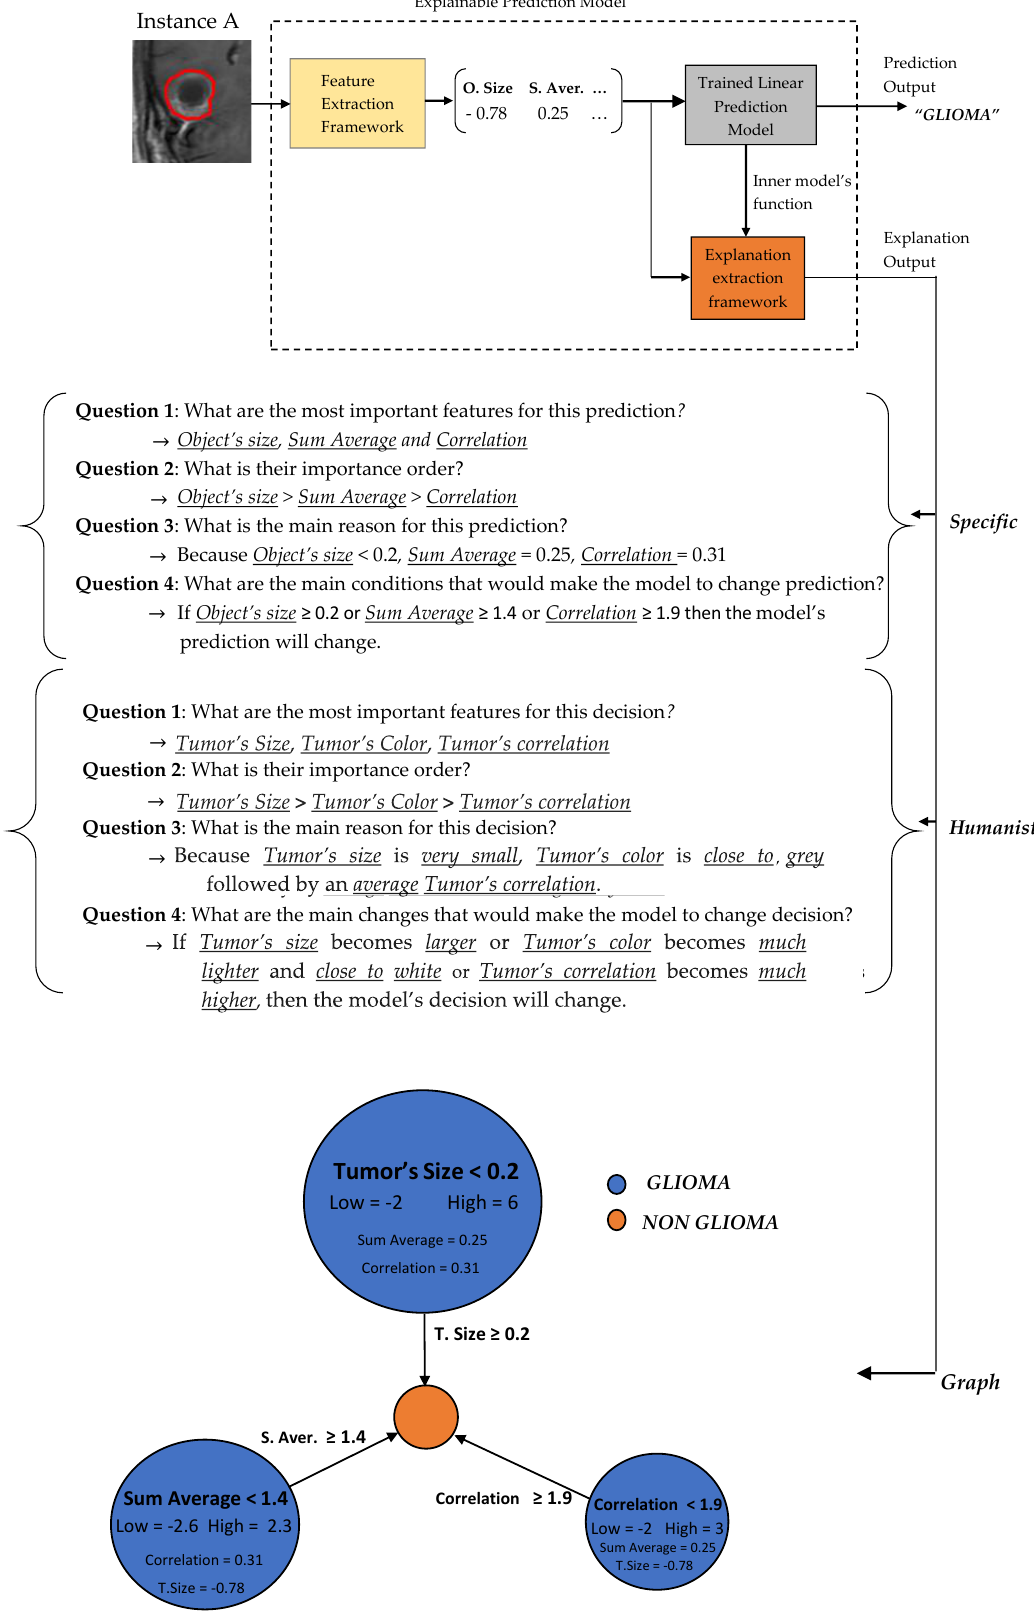
Figure 7. Explanation output for Instance A.